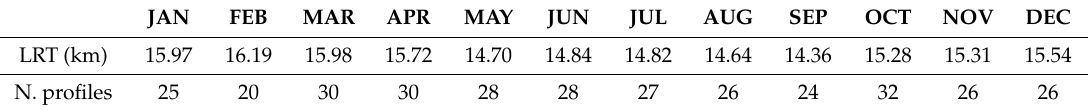
Figure 3. Vertical distribution of ozone concentration recorded on 15 February 2017 by balloon-sondes (blue line) and Microwave Limb Sounder (MLS) (black line) satellite over Irene.